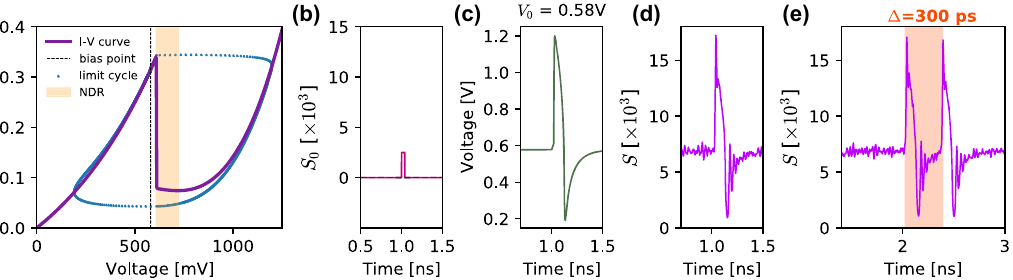
Figure 5: Numerical simulation of a PD-RTD-LD system. (a) I – V characteristic of a nano-scale RTD, with highlighted NDC region, voltage bias (fine dashed line) and evolution of the system states during the spiking event, showing the dynamical limit cycle. (b) Example of an electrical trigger signal. (c) Electrical response of the nano-RTD. (d) Optical response of a voltage-coupled nanoscale RTD-LD system. (e) Demonstration of firing of a pair of consecutive optical spikes, elicited in the system when subject to the arrival of a pair of input perturbations with temporal separation of 300 ps.